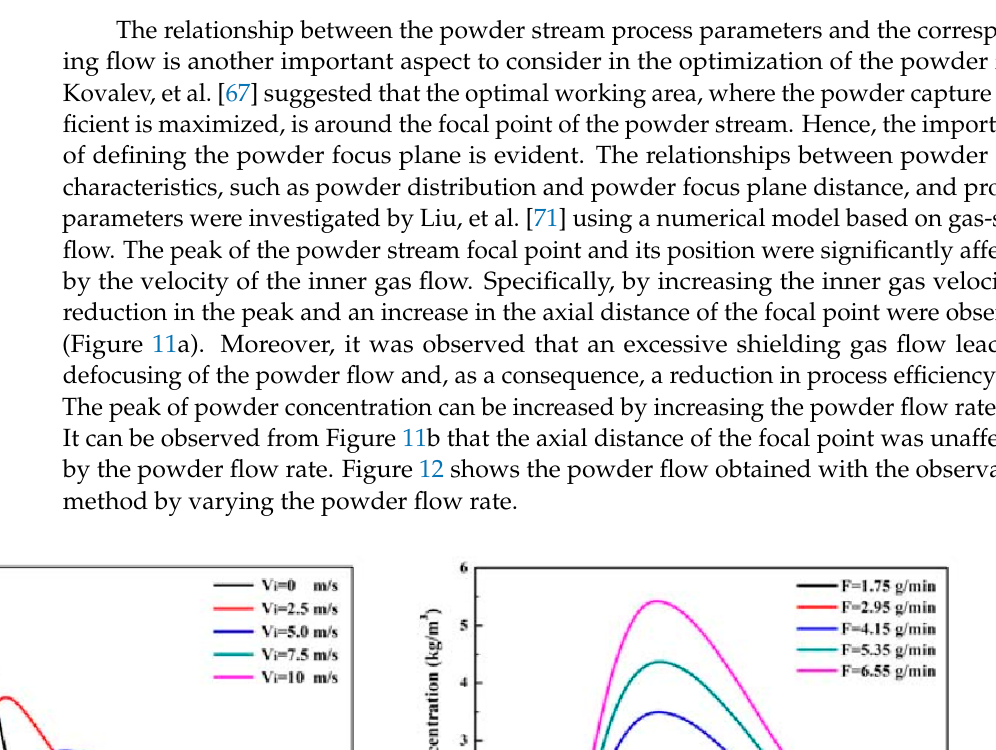
( c ) Figure 12. Powder distribution at different powder flow rates: ( a ) 0.052 g/s, ( b ) 0.075 g/s and ( c ) 0.088 g/s (reproduced with permission from [70]; Copyright © 2012 Elsevier).